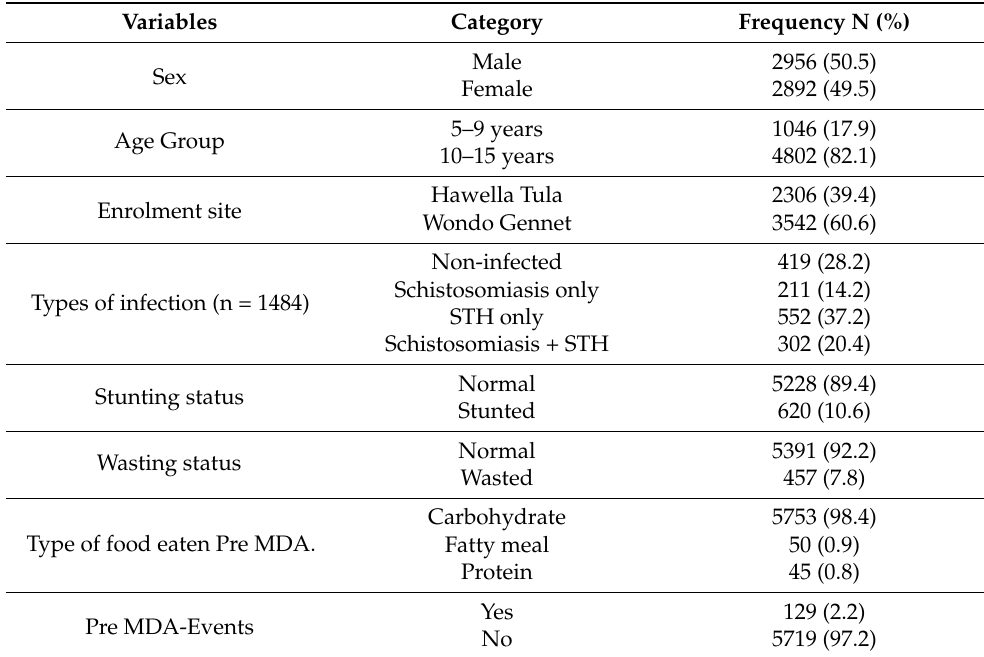
Table 1. Socio-demographic and baseline characteristics of study participants.